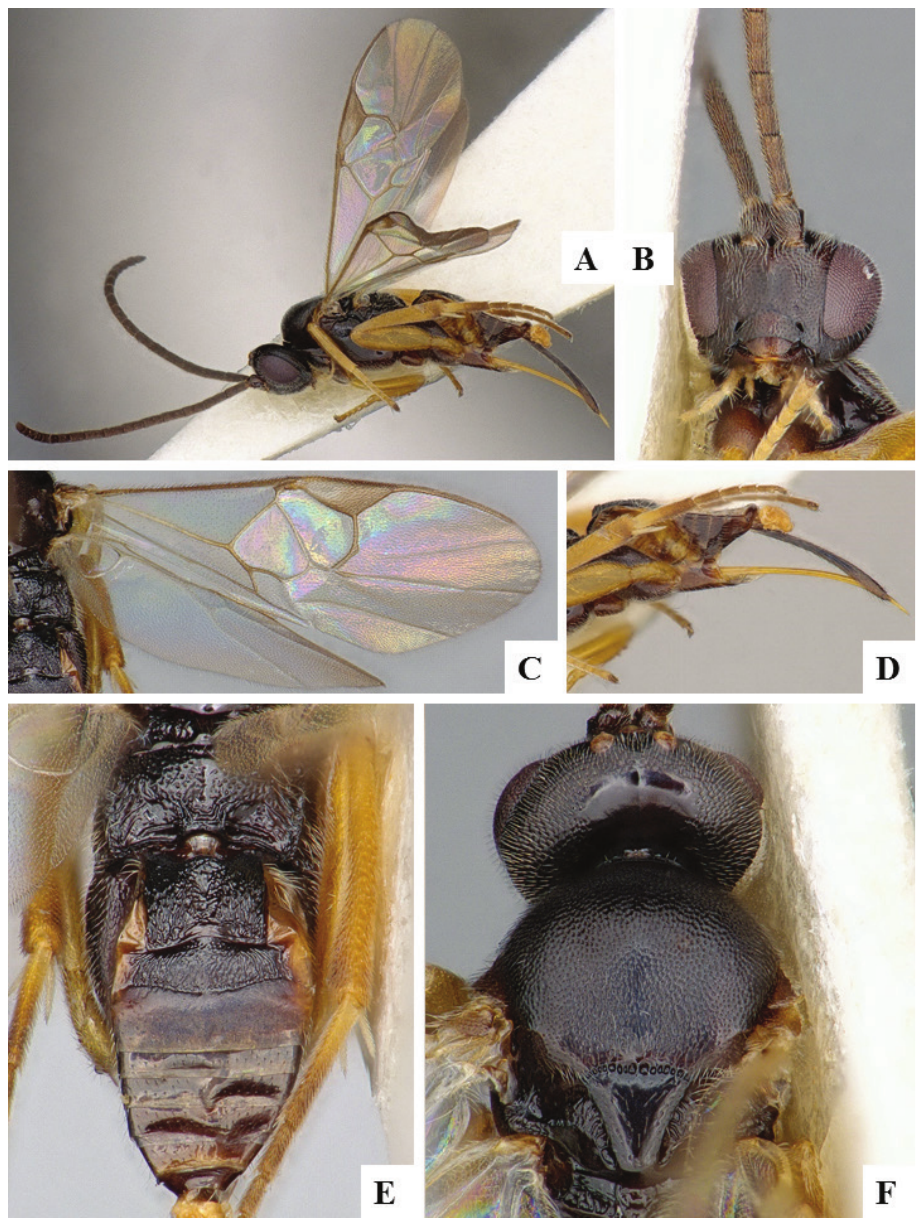
Figure 23. Dolichogenidea solenobiae. A Habitus, lateral B Head, frontal C Wings D Ovipositor sheaths and ovipositor E Metasoma, dorsal F Head and mesosoma,